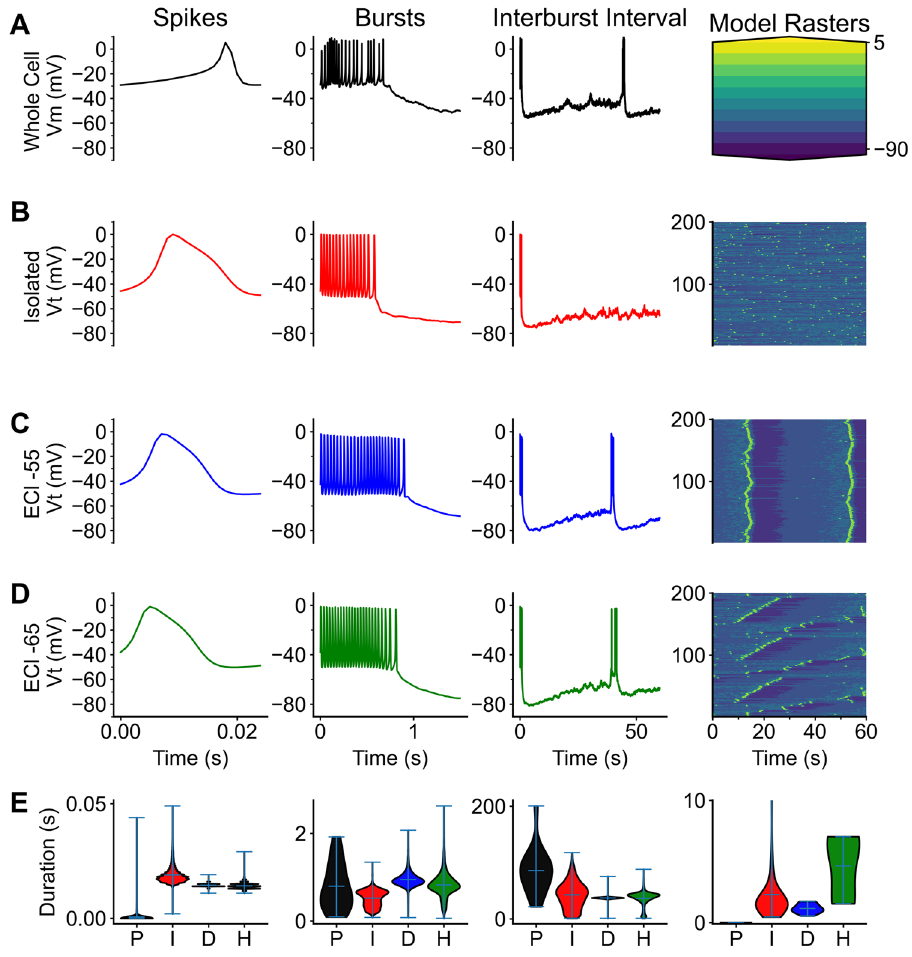
Figure 6. Comparison to physiological data. A comparison of physiological data from three different simulations. Each simulation is compared at 3 different timescales, spikes (0–25 ms), bursts(0–1 s), and interburst interval (0-60 s). ( A ) A representative trace from whole cell patch clamp. ( A ) column 4 is a color scalebar for the raster traced below in column 4. Traces in ( B ) are from a network simulation that does not receive any cholinergic or GABAergic stimulation. Traces in ( C ) result from a network with both GABA and acetylcholine neurotransmitter release. However, the reversal potential for chloride is set to − 55 mV causing GABA to be slightly depolarizing. Traces in ( D ) come from a network with both cholinergic and GABAergic stimulation, but with GABA acting as an inhibitory neurotransmitter. ( E ) Violin plots represent distributions of each dataset using the max interval algorithm. The key for violin plot x labels are: P = physiological, I = no GABA, no acetylcholine, D = depolarizing GABA, H = hyperpolarizing GABA. Column 1 is the spike duration, column 2 is the burst duration, column 3 is interburst interval, column 4 is wave